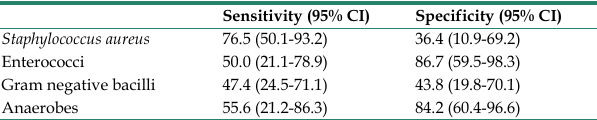
Table 3. Sensitivity and specificity of superficial wound swabs compared to deep bone